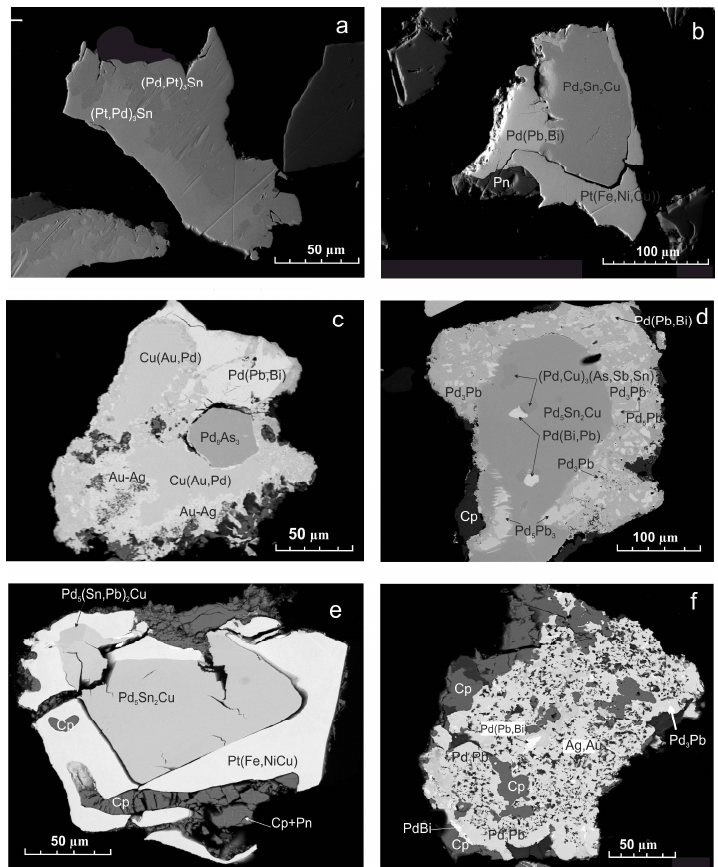
Figure 12. Back-scattered electrons images of the platinum group minerals in ore of the Southern orebody. Data in Tables 6–10. ( a )—intergrowth of atokite (Pd,Pt) 3 Sn and rustenburgite (Pt,Pd) 3 Sn; ( b )—intergrowth of polarite Pd(Pb,Bi) and stannopalladinite Pd 5 Sn 2 Cu in the frame of tetraferroplatinum Pt(Fe,Ni,Cu); ( c )—euchedral inclusion of stillwaterite Pd 8 As 3 in a aggregate consisting of polarite, tetra-auricupride Cu(Au,Pd) and Au-Ag alloy; ( d )—stannopalladinite containing the polarite and unnamed phase (Pd,Cu)(As,Sb,Sn) inclusions in the frame of a fine aggregate consisting of zvyagintsevite Pd 3 Pb, polarite and Pd 5 Pb 3 ; ( e )—crystal of stannopalladinite included in tetraferroplatinum in associations with chalcopyrite (Cp) and pentlandite (Pn); ( f )—microaggregate, consisting of zvyagintsevite, polarite, Au-Ag alloy and chalcopyrite. Data in Tables 6–10.